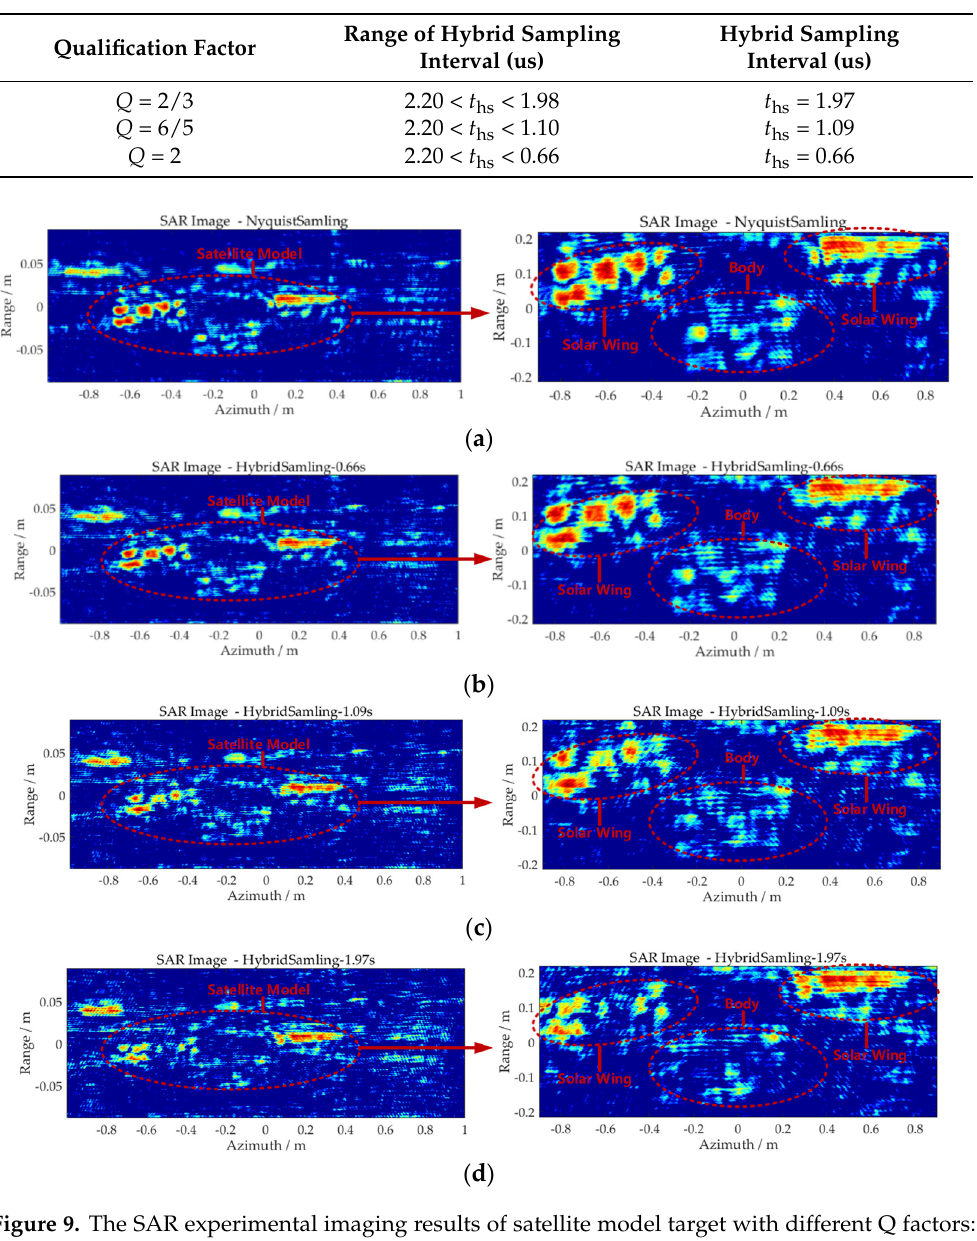
Table 6. The interval between two adjacent hybrid samplings in experiment.